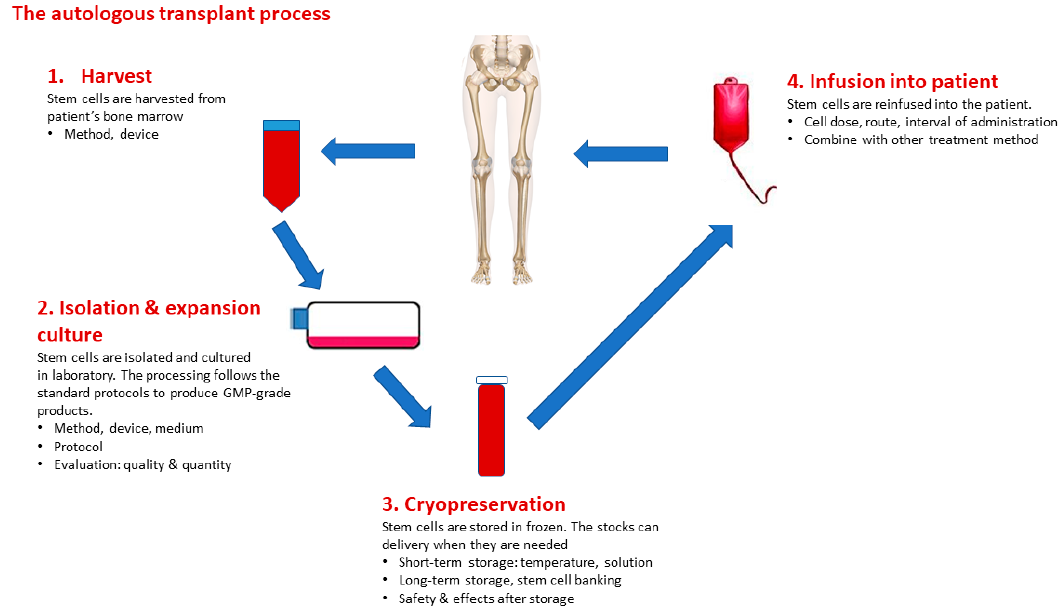
Figure 2. The process of bone marrow mesenchymal stem cell transplantation.